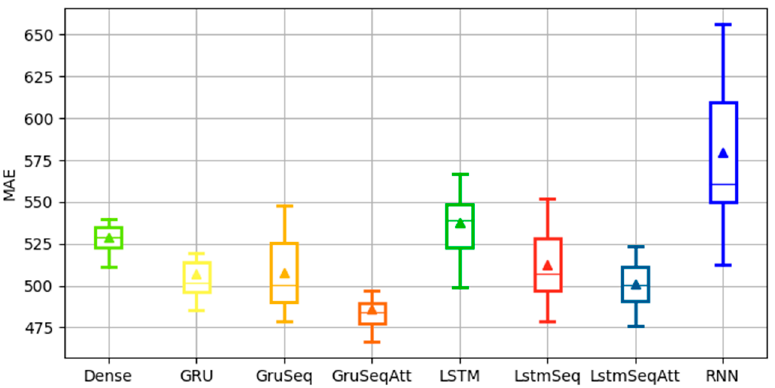
Figure 6. MAE box line diagram for different models.